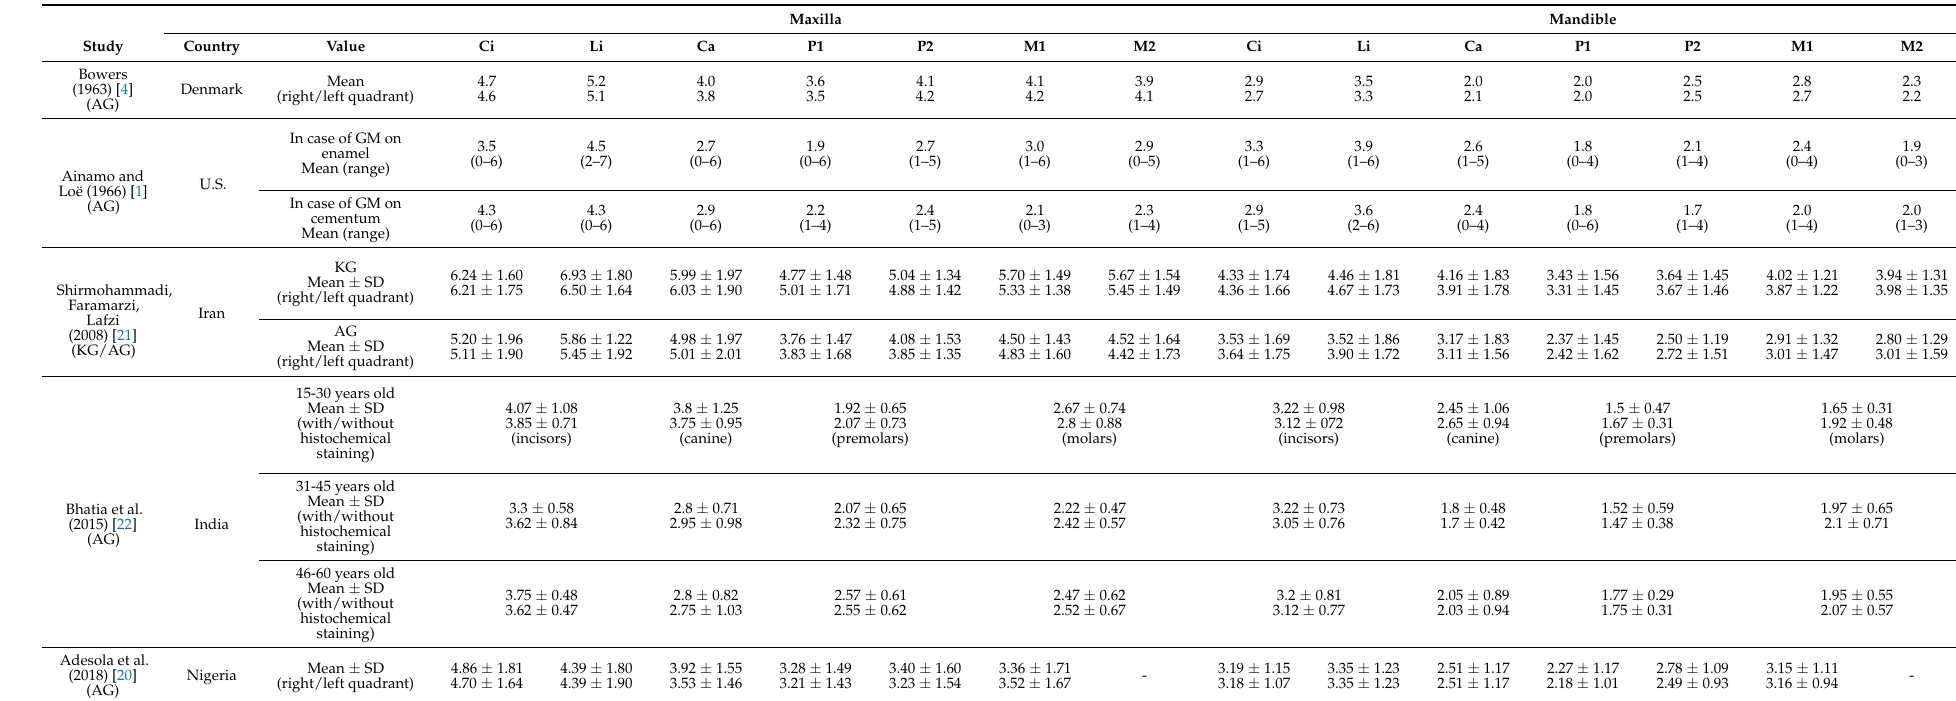
Table A4. Comparison of the gingival dimensions in previous